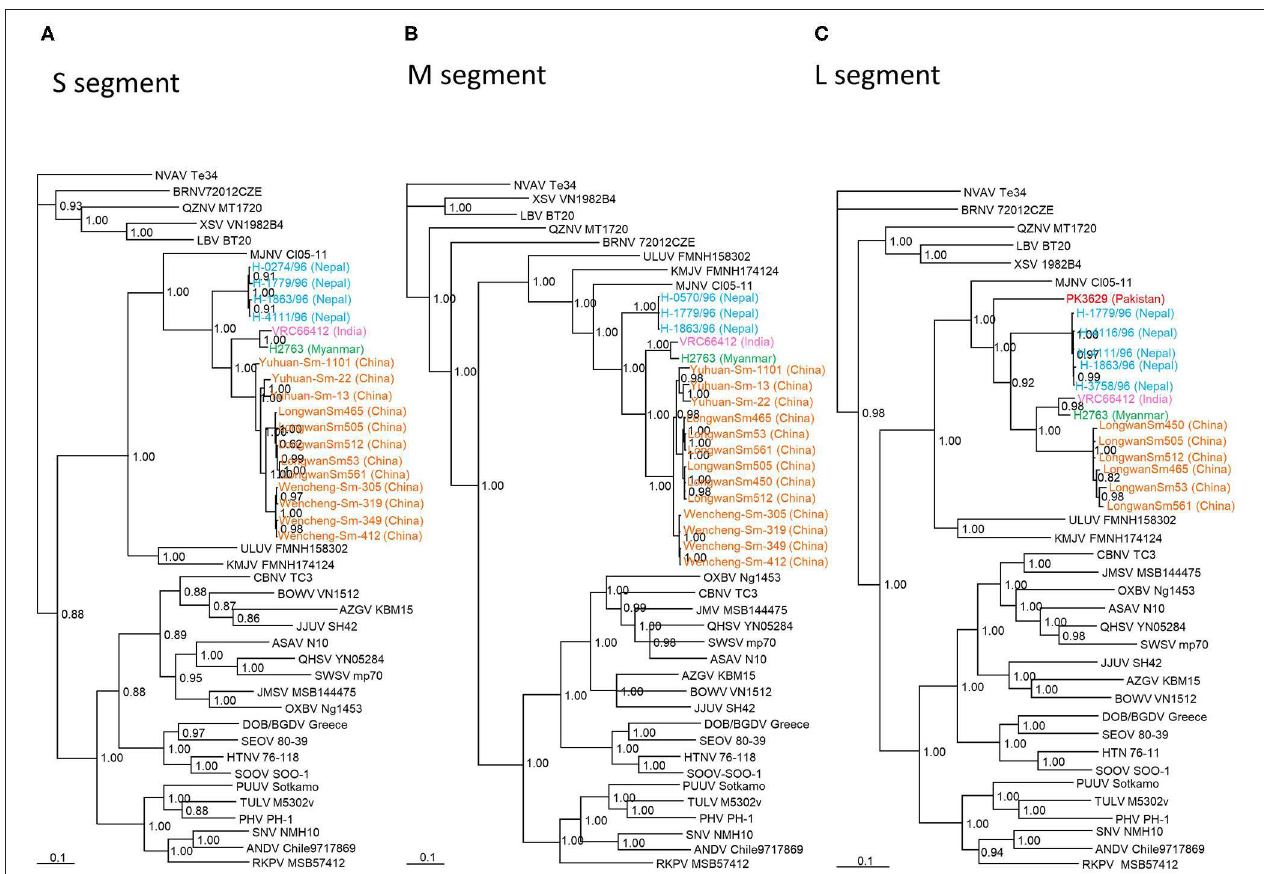
FIGURE 2 | Phylogenetic trees generated by the Bayesian method, under the best-fit GTR + I + Γ model of evolution, based on the partial S-, M-, and L-genomic segments of TPMV strains H2763 (S: MT225396; M: MT225397; L: MT225398) in Myanmar and PK3629 in Pakistan (L: MT225399), and other representative hantaviruses. The phylogenetic positions of TPMV strains VRC66412 (S: AY526097, M: EU001329, L: EU001330) in India; TPMV strains LongwanSm53 (S: JF784172; M: JF784178; L: KJ420575), LongwanSm450 (S: JF784173, M: JF784179, L: KJ420576), LongwanSm465 (S: JF784174, M: JF784180), LongwanSm505 (S: JF784175, M: JF784181), LongwanSm512 (S: JF784176, M: JF784182), LongwanSm561 (S: JF784177, M: JF784183), Wencheng-Sm-305 (S: KJ420560, M: KJ420542), Wencheng-Sm-319 (S: KJ420561, M: KJ420543, L: KJ420569), Wencheng-Sm-349 (S: KJ420562, M: KJ420544, L: KJ420570), Wencheng-Sm-412 (S: KJ420563, M: KJ420545, L: KJ420571), Yuhuan-Sm-13 (S: KJ420564, M: KJ420546, L: KJ420572), Yuhuan-Sm-22 (S: KJ420565, M: KJ420547, L: KJ420573), and Yuhuan-Sm-1101 (S: KJ420566, M: KJ420548, L: KJ420574) in China; strains H-1091/96 (S: HQ831358), H-0274/96 (S: HQ831359), H-0570/96 (S: HQ831360, M: HQ831376), H-0898/96 (S: HQ831361), H-1779/96 (S: HQ831362, M: HQ831375, L: HQ831374), H-1863/96 (S: HQ831363, M: HQ831377, L: HQ831373), H-3753/96 (S: HQ831364), H-3758/96 (S: HQ831365, L: HQ831372), H-3858/96 (S: HQ831366), H-4066/96 (S: HQ831367), H-4111/96 (S: HQ831368, L: HQ831371), and H-4116/96 (S: HQ831369, L: HQ831370) in Nepal are shown in relationship to Imjin thottimvirus (MJNV Cl05-11, S: EF641804; M: EF641798; L: EF641806) from Crocidura lasiura , Uluguru thottimvirus (ULUV FMNH158302, S: JX193695; M: JX193696; L: JX193697) from Myosorex geata , Kilimanjaro thottimvirus (KMJV FMNH174124, S: JX193698; M: JX193699; L: JX193700) from Myosorex zinki , Jeju orthohantavirus (JJUV SH42, S: HQ663933; M: HQ663934; L: HQ663935) from Crocidura shantungensis , Oxbow orthohantavirus (OXBV Ng1453, S: FJ5339166; M: FJ539167; L: FJ593497) from Neurotrichus gibbsii , Cao Bˇang orthohantavirus (CBNV TC-3, S: EF543524; M: EF543526; L: EF543525) from Anourosorex squamipes , Azagny orthohantavirus (AZGV KBM15, S: JF276226; M: JF276227; L: JF276228) from Crocidura obscurior , Bowé orthohantavirus (BOWV VN1512, S: KC631782; M: KC631783; L: KC631784) from Crocidura douceti , Qian Hu Shan orthohantavirus (QHSV YN05-284, S: GU566023; M: GU566022; L:GU566021) from Sorex cylindricauda , Seewis orthohantavirus (SWSV mp70, S: EF636024; M: EF636025; L: EF636026) from Sorex araneus , Jemez Springs orthohantavirus from Sorex monticolus (JMSV MSB144475, S: FJ593499; M: FJ593500; L: FJ593501), Asama orthohantavirus (ASAV N10, S: EU929072; M: EU929075; L: EU929078) from Urotrichus talpoides , Nova mobatvirus (NVA Te34, S: KR072621, M: KR072622, L: KR072623) from Talpa europaea , and Rockport orthohantavirus (RKPV MSB57412, S: HM015223; M: HM015222; L: HM015221) from Scalopus aquaticus . Also shown are representative rodent-borne hantaviruses, including Sin Nombre orthohantavirus (SNV NMH10, S: NC_005216; M: NC_005215; L: NC_005217), Andes orthohantavirus (ANDV Chile9717869, S: AF291702; M: AF291703; L: AF291704), Prospect Hill orthohantavirus (PHV PH-1, S: Z49098; M: X55129; L: EF646763), Tula orthohantavirus (TULV M5302v, S: NC_005227; M: NC_005228; L: NC_005226), Puumala orthohantavirus (PUUV Sotkamo, S: NC_005224; M: NC_005223; L: NC_005225), Dobrava/Belgrade orthohantavirus (DOB/BGDV Greece, S: NC_005233; M: NC_005234; L: NC_005235), Hantaan orthohantavirus (HTNV 76-118, S: NC_005218; M: NC_005219; L: NC_005222) and Seoul orthohantavirus (SEOV 80-39, S: NC_005236; M: NC_005237; L: NC_005238), and bat-borne hantaviruses, Brno loanvirus (BRNV 7/2012/CZE, S: KX845678; M: KX845679; L: KX845680) from Nyctalus noctula , Láibin mobatvirus (LAIV BT20, S: KM102247; M: KM102248; L: KM102249) from Taphozous melanopogon , Xuân Son mobatvirus (XSV VN1982B4, S: KC688335; L: JX912953) from Hipposideros pomona and Quezon mobatvirus (QZNV MT1720/1657, S: KU950713; M: KU950714; L: KU950715) from Rousettus amplexicaudatus , respectively. The numbers at each node are posterior node probabilities based on 45,000 trees: two replicate Markov chain Monte Carlo runs consisting of six chains of two million generations each sampled every 100 generations with a burn-in of 7,500 (25%). The scale bar indicates nucleotide substitutions per site. (A) S-segment, (B) M-segment, (C) L-segment phylogenetic trees. Color of TPMV strains: red (Pakistan); orange (China); green (Myanmar); light blue (Nepal); pink (India).